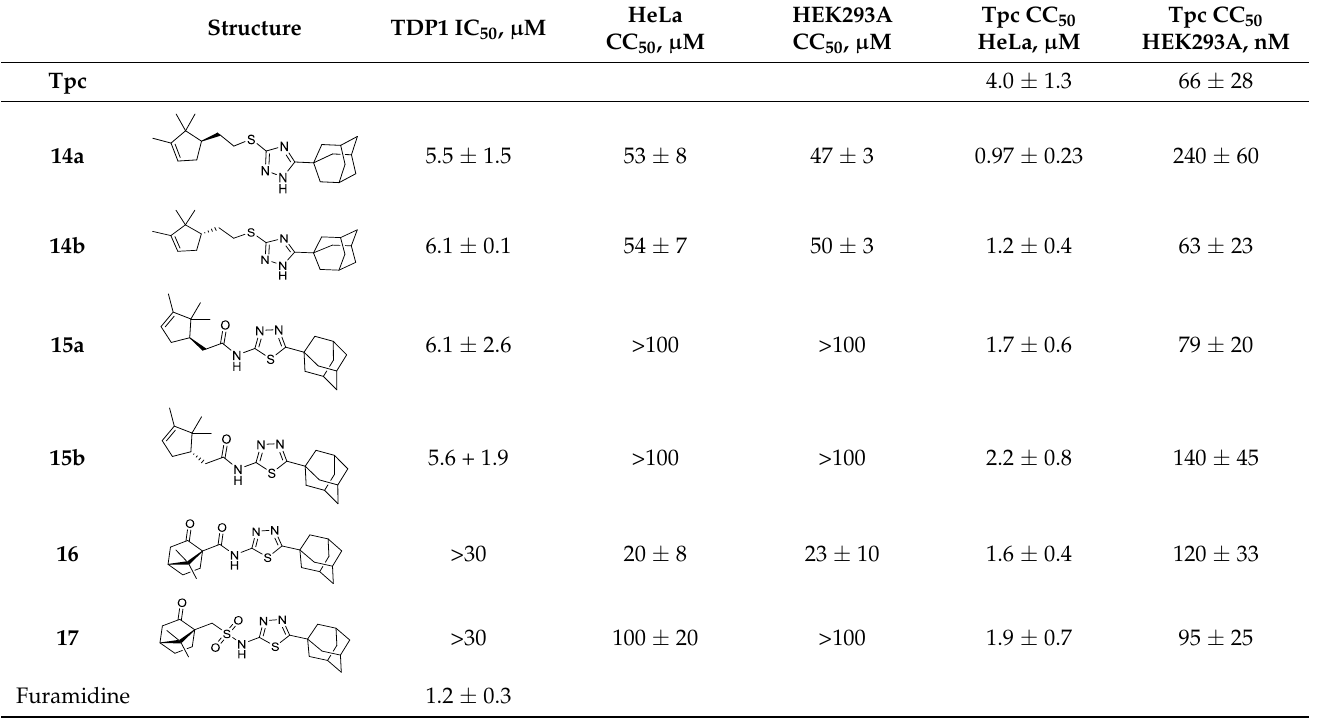
Table 1. Data on TDP1 inhibition (IC 50 ) as well as cytotoxicity (CC 50 ) on HeLa and HEK293A cell lines. Furthermore, the influence on topotecan ( Tpc) cytotoxicity was measured. Structure